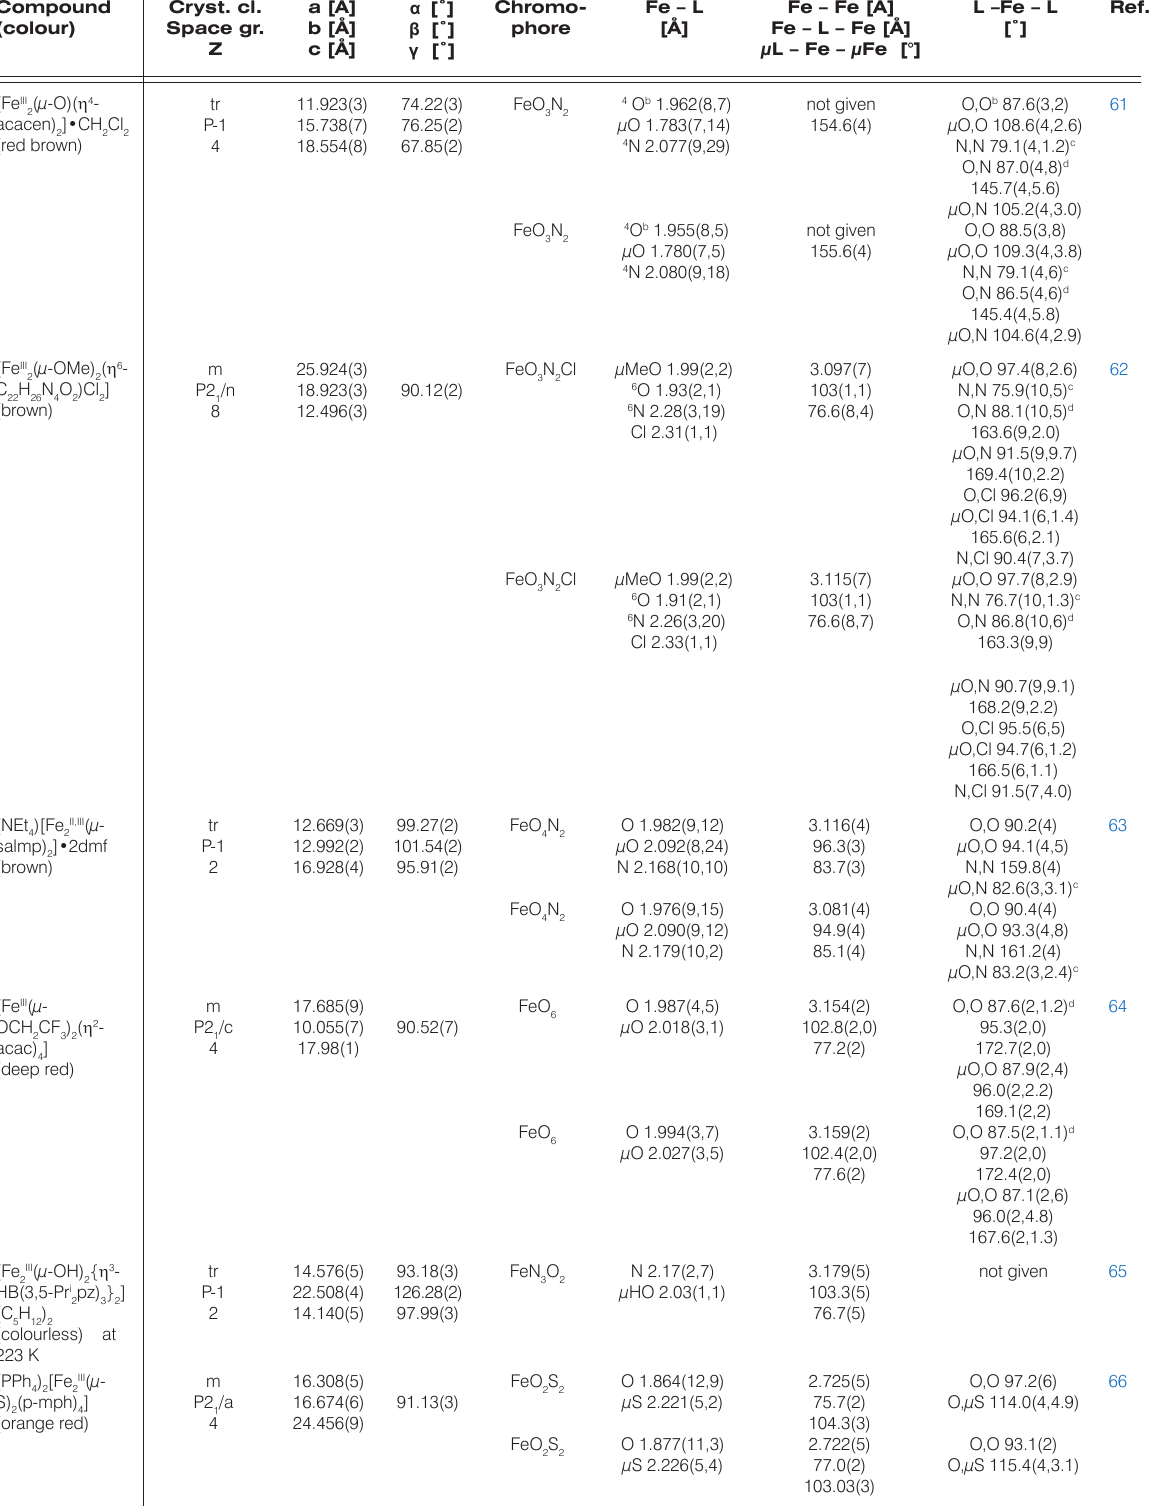
Table 4. Crystallographic and structural data for di- , tetra- and hexameric iron coordination compounds – independent molecules, distortion isomers a